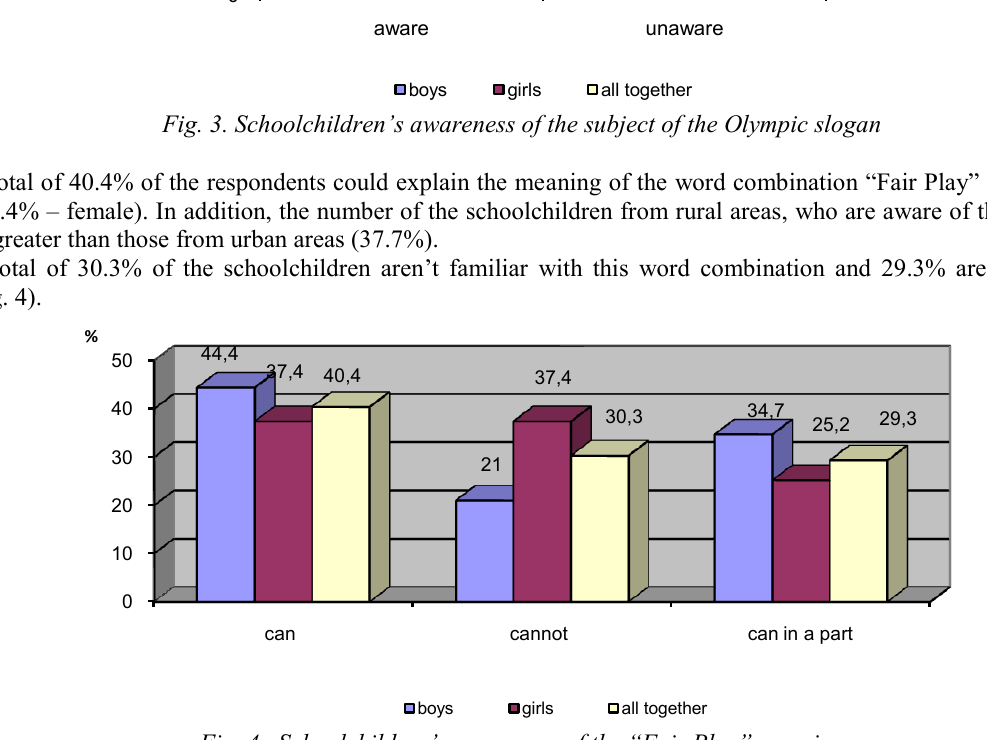
Fig. 4. Schoolchildren’s awareness of the “Fair Play” meaning